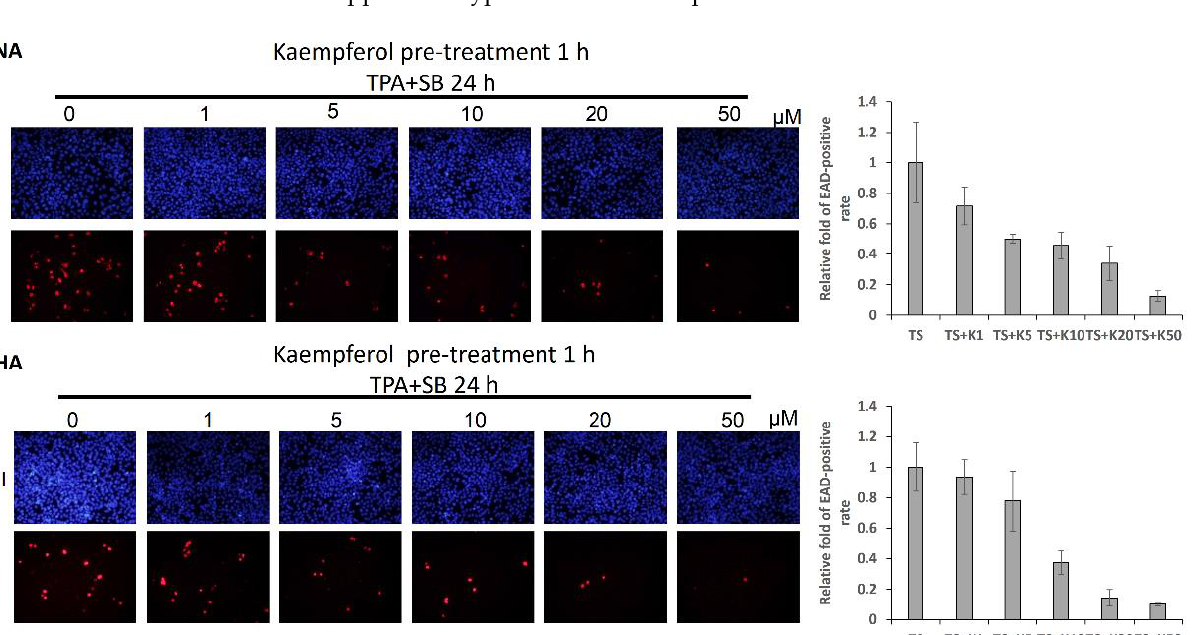
Figure 2. Kaempferol treatment inhibits EBV reactivation in NPC cell lines. ( a ) NA and ( b ) HA cell lines were prepared for the detection of the effects of kaempferol treatment on EBV reactivation. For